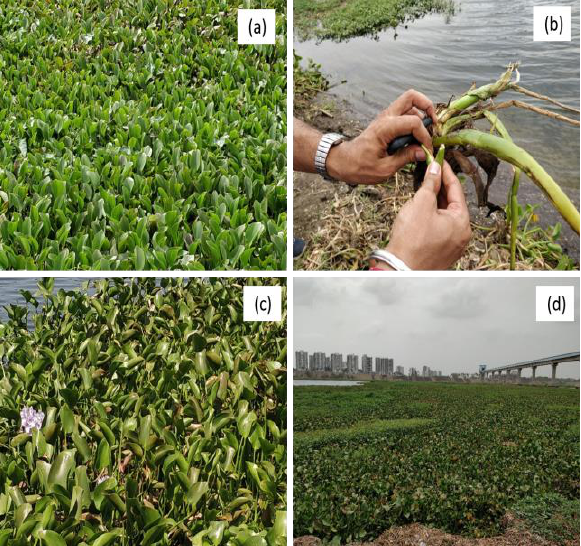
Figure 1. Field photographs of water hyacinth over the Tapi River, close to Surat City in chronical order from left to right, (a) Water Hyacinth, (b) fibrous tissue, (c) Purple flower and (d) monospecific